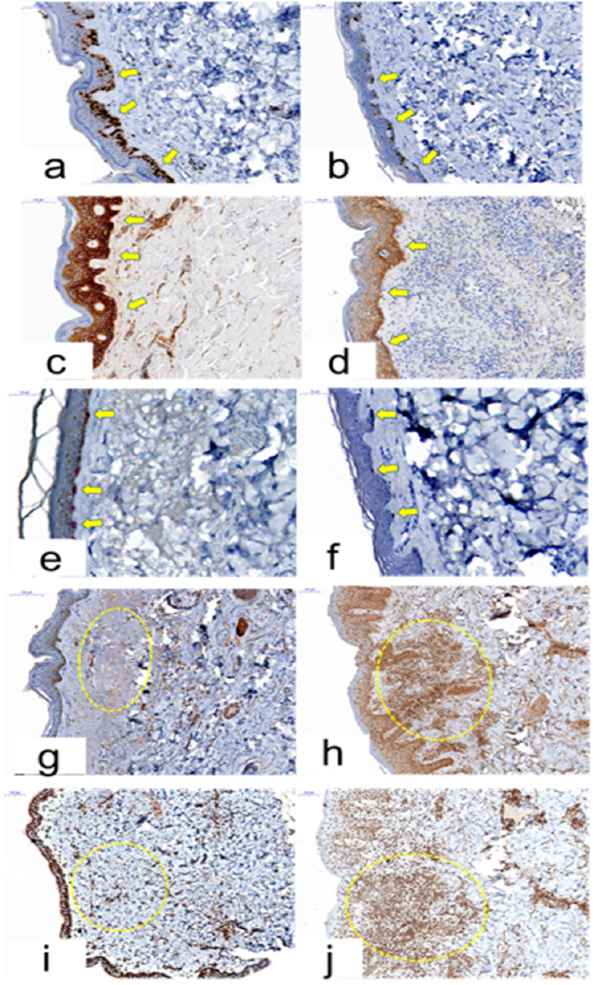
Figure 6. Pathologic comparison between normal control and patient who had EGFRI-related side effects (ERSE). (x 200) Expression of Ki-67 in the nucleus of keratinocytes in the epidermal basal, para-basal cell layer ( a: control, b: ERSE). Expression of EGFR in the membrane of keratinocytes in the epidermal basal cell layer ( c: control, d : ERSE). Cytoplasmic Melan-A expression was seen in the basal melanocytes of the epidermis ( e : control, f: ERSE). Cytoplasmic IL-17 expression in the dermis ( g : control, h : ERSE) and Nuclear with or without cytoplasmic TNF- α expression in the dermis and epidermis ( i: control, j: ERSE).